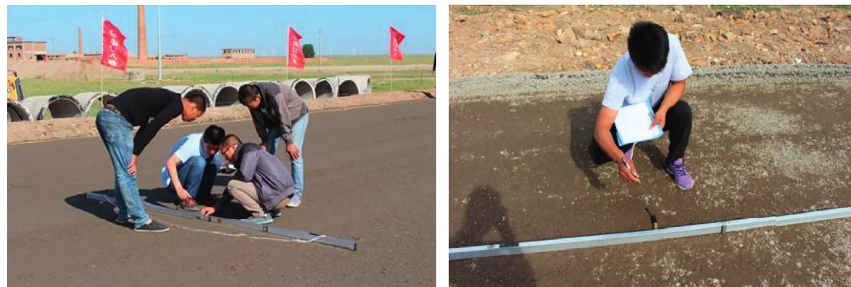
Figure 6: Longitudinal and horizontal evenness detection.